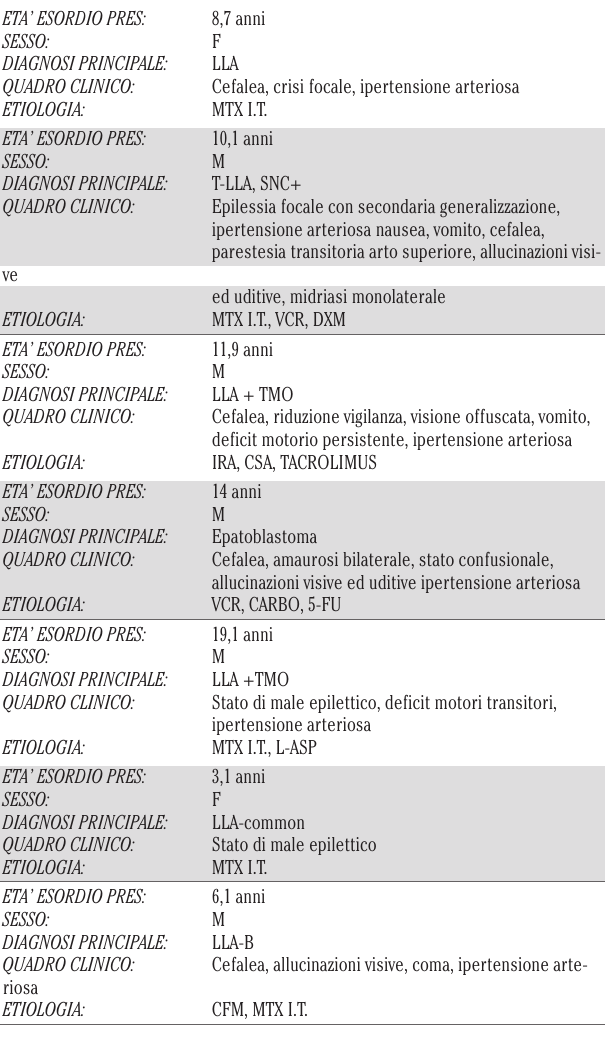
Caratteristiche dei pazienti con diagnosi di